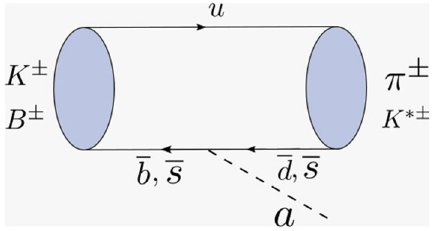
Fig. 1 Tree level diagram contribution to the FCNC processes K ± → π ± a and B ± → K ∗±